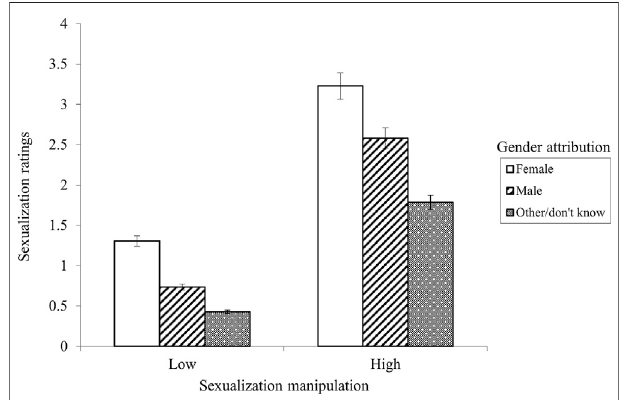
FIGURE 6 | Sexualization ratings (with 95% con fi dence interval) for level of manipulated sexualization by gender attributed to the PLD.